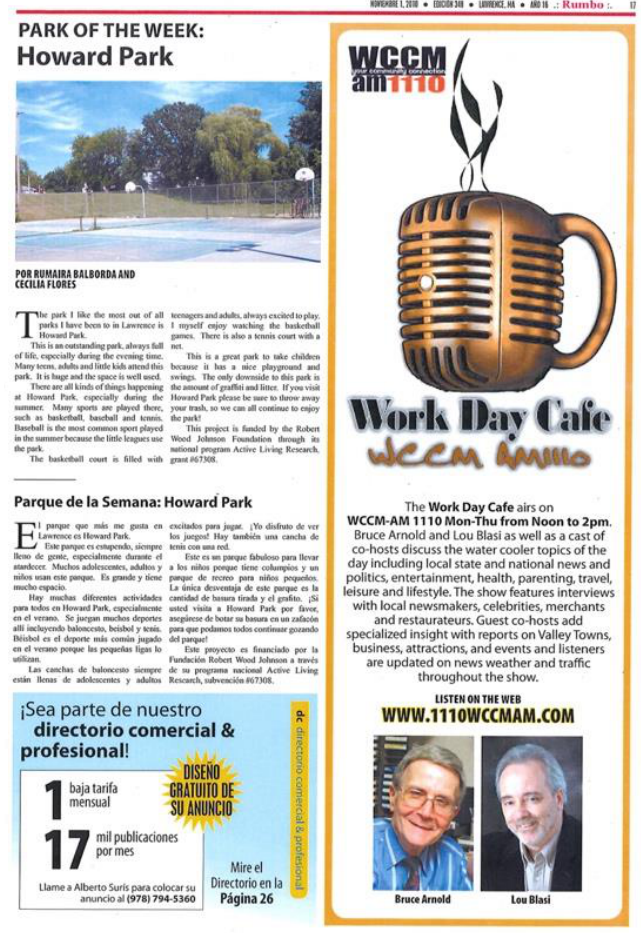
Figure 3. “Park of the Week” from November 2010 edition, Rumbo News [45].